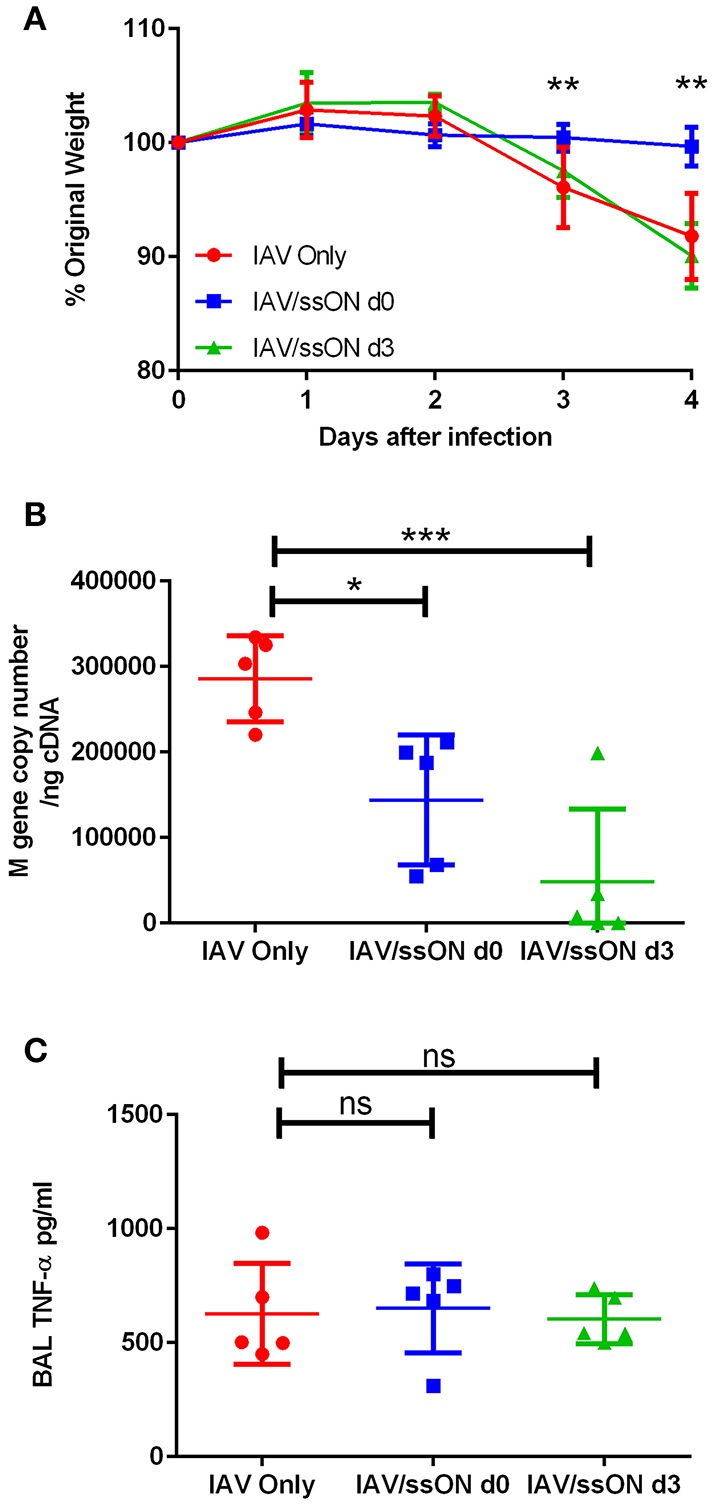
Reduced IAV load in the lungs of mice after treatment with ssON. BALB/c mice were infected intranasally with IAV. One group were untreated (red circles), a second group received 25 μg of ssON (blue squares) intranasally at the same time as the viral challenge and a third group received an intranasal treatment of 25 μg ssON 3 days post-infection (green triangles). (A) The mice were weighed daily and subsequently sacrificed day 4 after infection. The (B) viral load was measured in the lungs and (C) the TNF-α levels present in the bronchoalveolar lavage (BAL) were measured by ELISA. Statistical calculations were made using one-way ANOVA. Data represent one experiment out of two and data for individual mice are shown in (B,C). P-value: not significant (ns) P > 0.05; *P ≤ 0.05; **P ≤ 0.01; ***P ≤ 0.001.